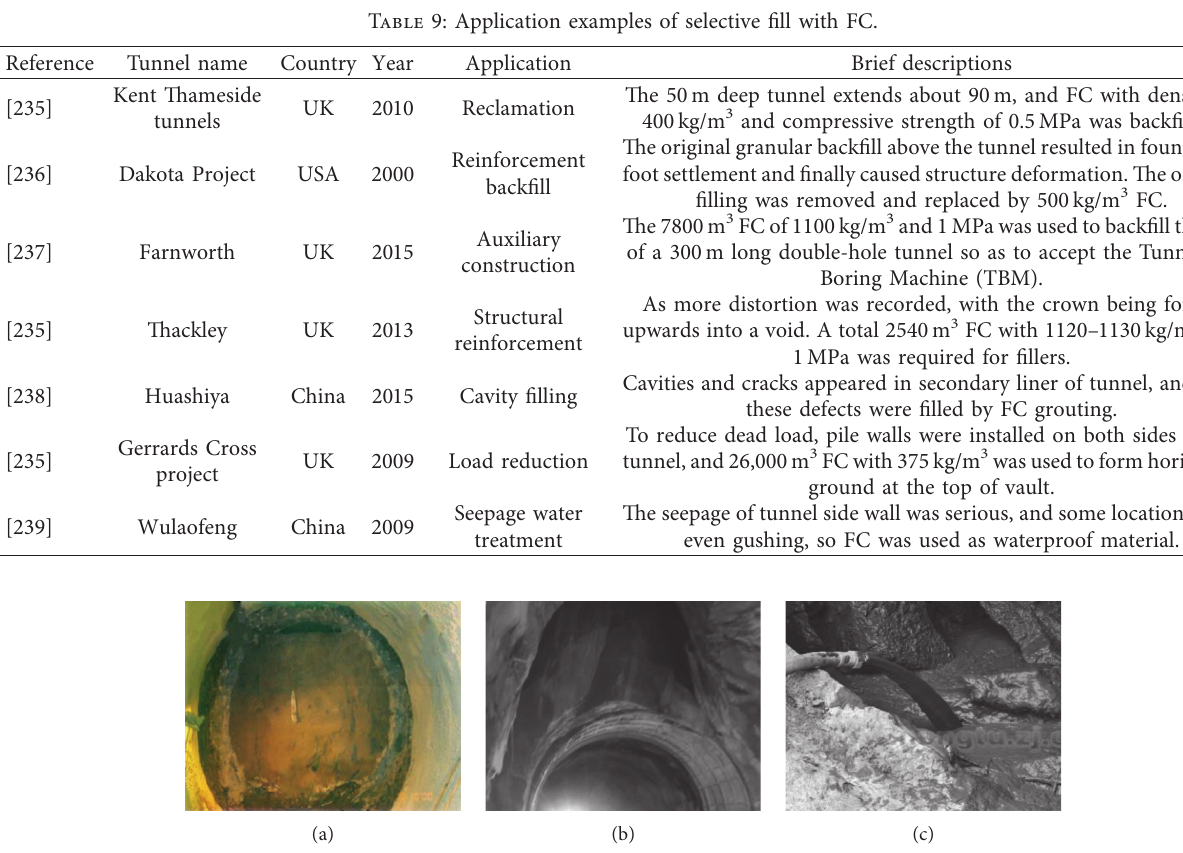
Figure 5: (a) Bolu highway twin tunnel [240], (b) collapse, and (c) treatment with pumped FC in Shima tunnel